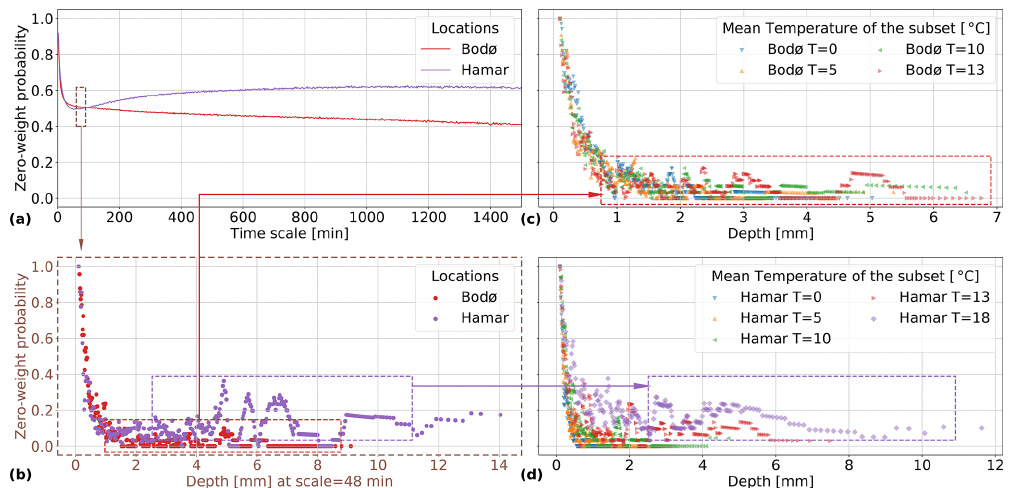
Figure 3. Dependency of the probability to have a weight equal to zero on timescale (a) , rainfall depth (b) , and temperature (c, d) for datasets observed in Bodø and Hamar. Panels (b) , (c) , and (d) are based on data at 48min